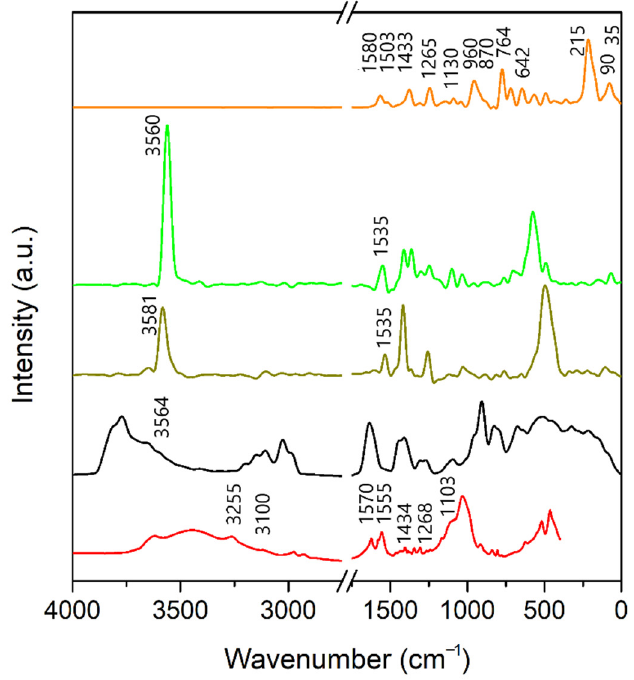
Figure 5. The experimental (red) and calculated VDOS (black), the projected VDOS of the NH1 group (green), the projected VDOS of the NH2 group (olive) and the projected VDOS of the triazine ring (orange) for the A-TMP-Mt model.